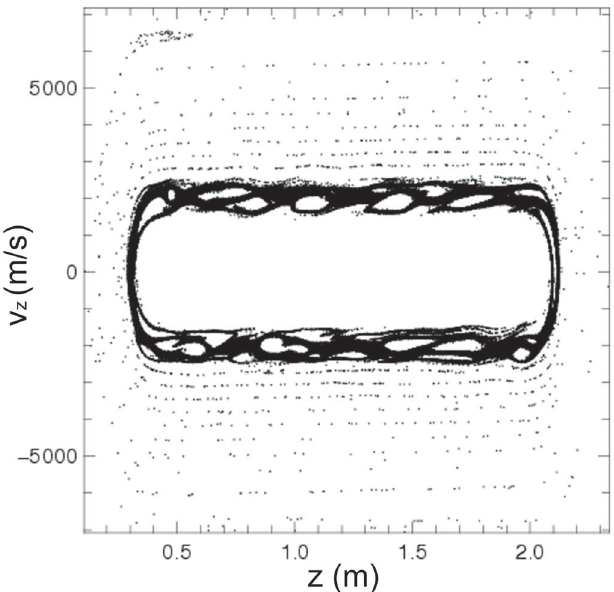
(cid:2) 52 : 2 kHz for q